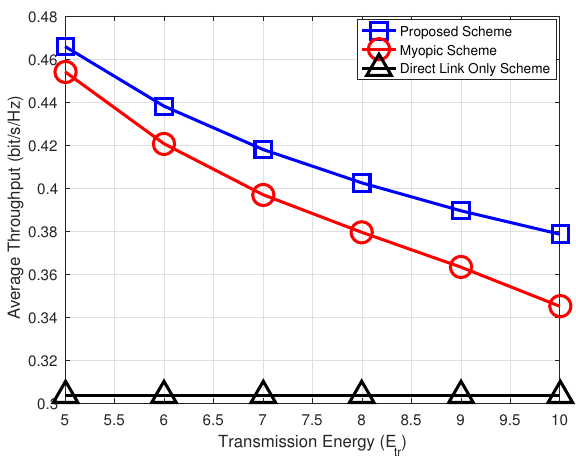
Figure 5. Average throughput versus required transmitted